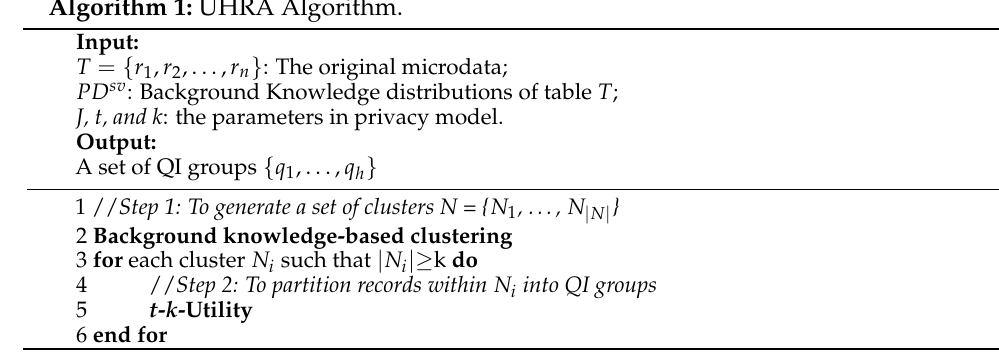
Algorithm 1: UHRA